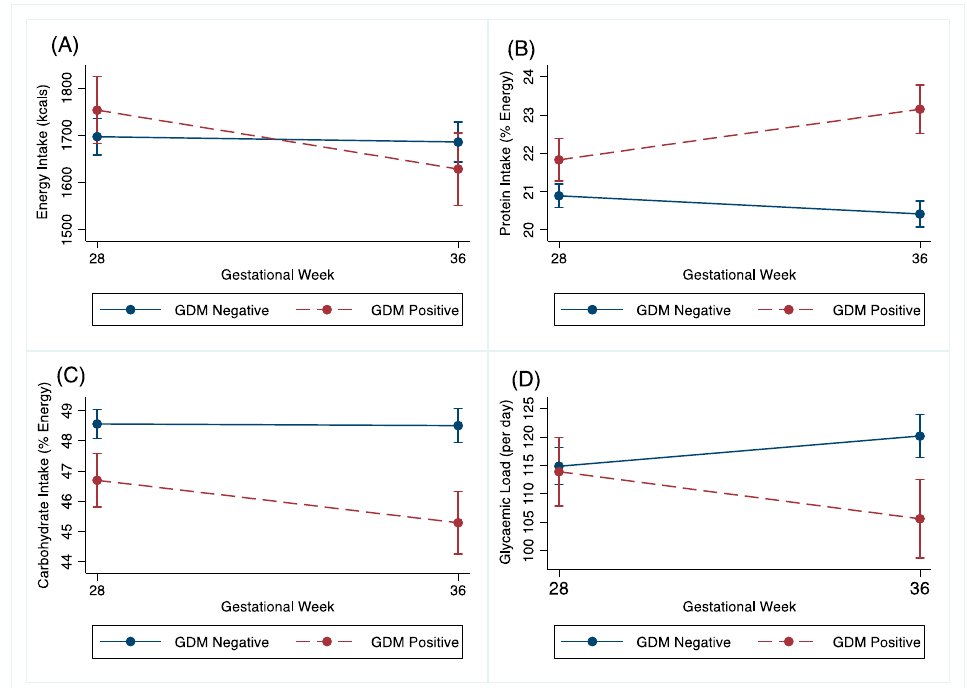
Figure 3. Unadjusted ( A ) energy (kcals), ( B ) protein (% energy), ( C ) carbohydrate (% energy) and ( D ) glycaemic load change of GDM and non-GDM women from 27 +0 –28 +6 weeks’ gestation (28 weeks) to 34–36 weeks’ gestation (36 weeks), with 95% confidence intervals.